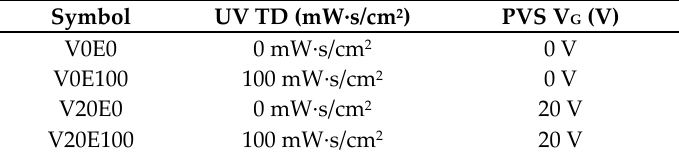
Table 1. Symbol list for various UV TD and PVS conditions applied simultaneously on F-SOHOS.